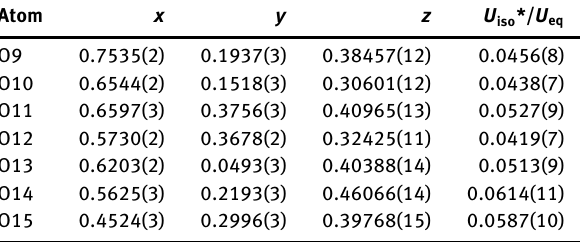
Table 2: Fractional atomic coordinates and isotropic or equivalent isotropic displacement parameters (Å 2